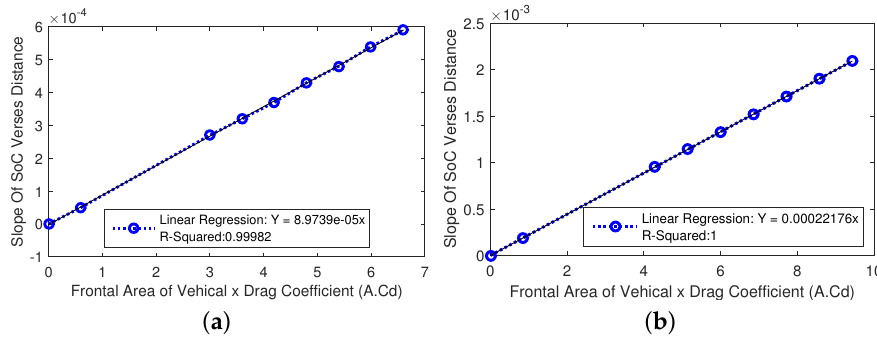
Figure 4. SoC versus distance for different frontal areas of the vehicle: ( a ) SORT 3; and ( b ) HWFET. Table 2. Driving cycle constants. UDDS, Urban Dynamometer Driving Schedule.